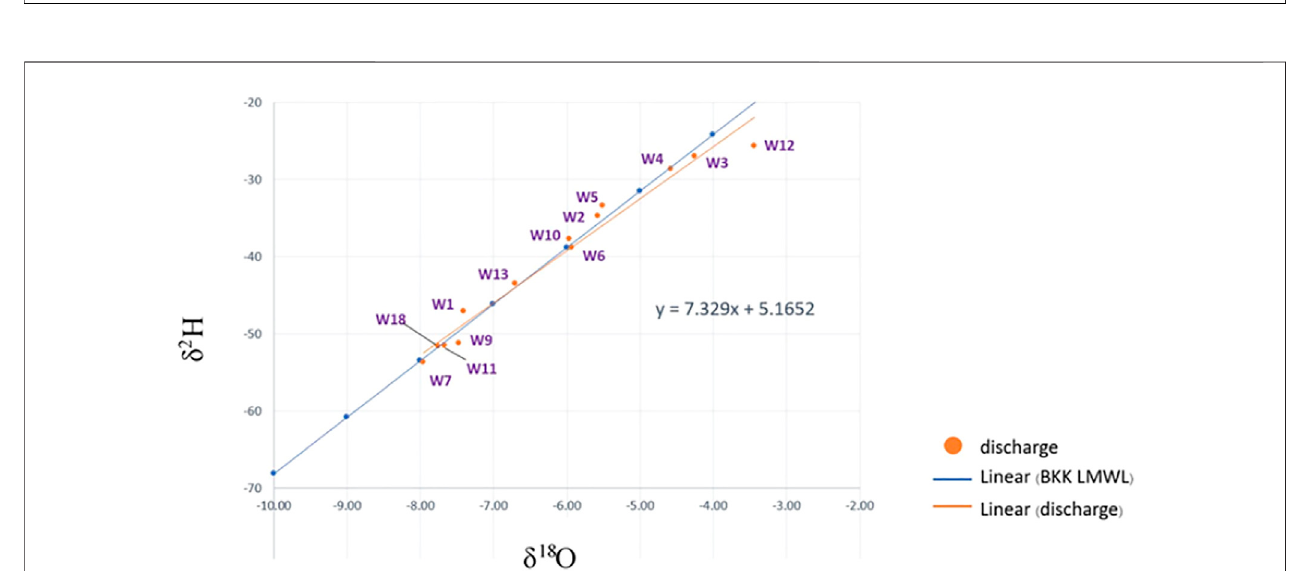
FIGURE 4 | δ 2 H and δ 18 O of groundwater in the study area compared with the Bangkok Local Meteoric Water Line (BKK LMWL).